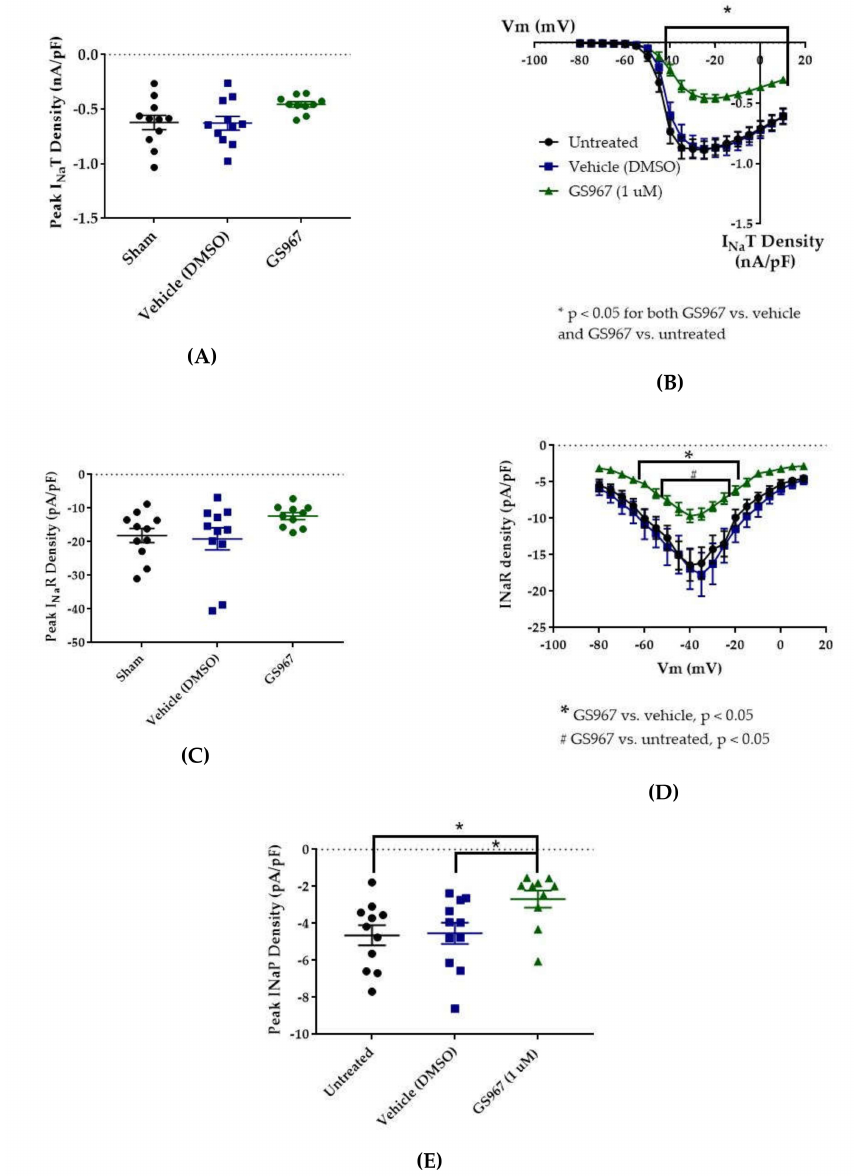
Figure 6. E ff ects of GS967 on WT hNav1.2 in stable HEK cell lines. The Nav β 4 peptide was included in the pipette solution for all experiments with GS967. ( A ) The maximal peak transient current density of each cell is plotted; average and SEM for each group is indicated by bars. Significance was determined by one-way ANOVA. n = 11 untreated, 11 vehicle, 10 GS967. ( B ) The maximal peak resurgent current density of each cell is plotted; average and SEM for each group is indicated by bars. Significance was determined by two-way ANOVA with Tukey’s multiple comparisons. * p < 0.05 for both GS967 vs. vehicle and GS967 vs. untreated. n = 11 untreated, 11 vehicle, 10 GS967. ( C ) The maximal peak resurgent current density of each cell is plotted; average and SEM for each group is indicated by bars. Significance was determined by one-way ANOVA. n = 11 untreated, 11 vehicle, 10 GS967. ( D ) Average current densities elicited by voltage steps from -80 to + 10 mV. Significance was determined by two-way ANOVA with Tukey’s multiple comparisons. * p < 0.05, GS967 vs. vehicle, # p < 0.05, GS967 vs. untreated. n = 11 untreated, 11 vehicle, 9 GS967. ( E ) Average peak resurgent current densities over a range of voltages from -65 to + 5 mV. Significance was determined by Kruskal–Wallis test with Dunn’s multiple comparisons. n = 11 untreated, 11 vehicle, 10 GS967. DMSO = dimethyl